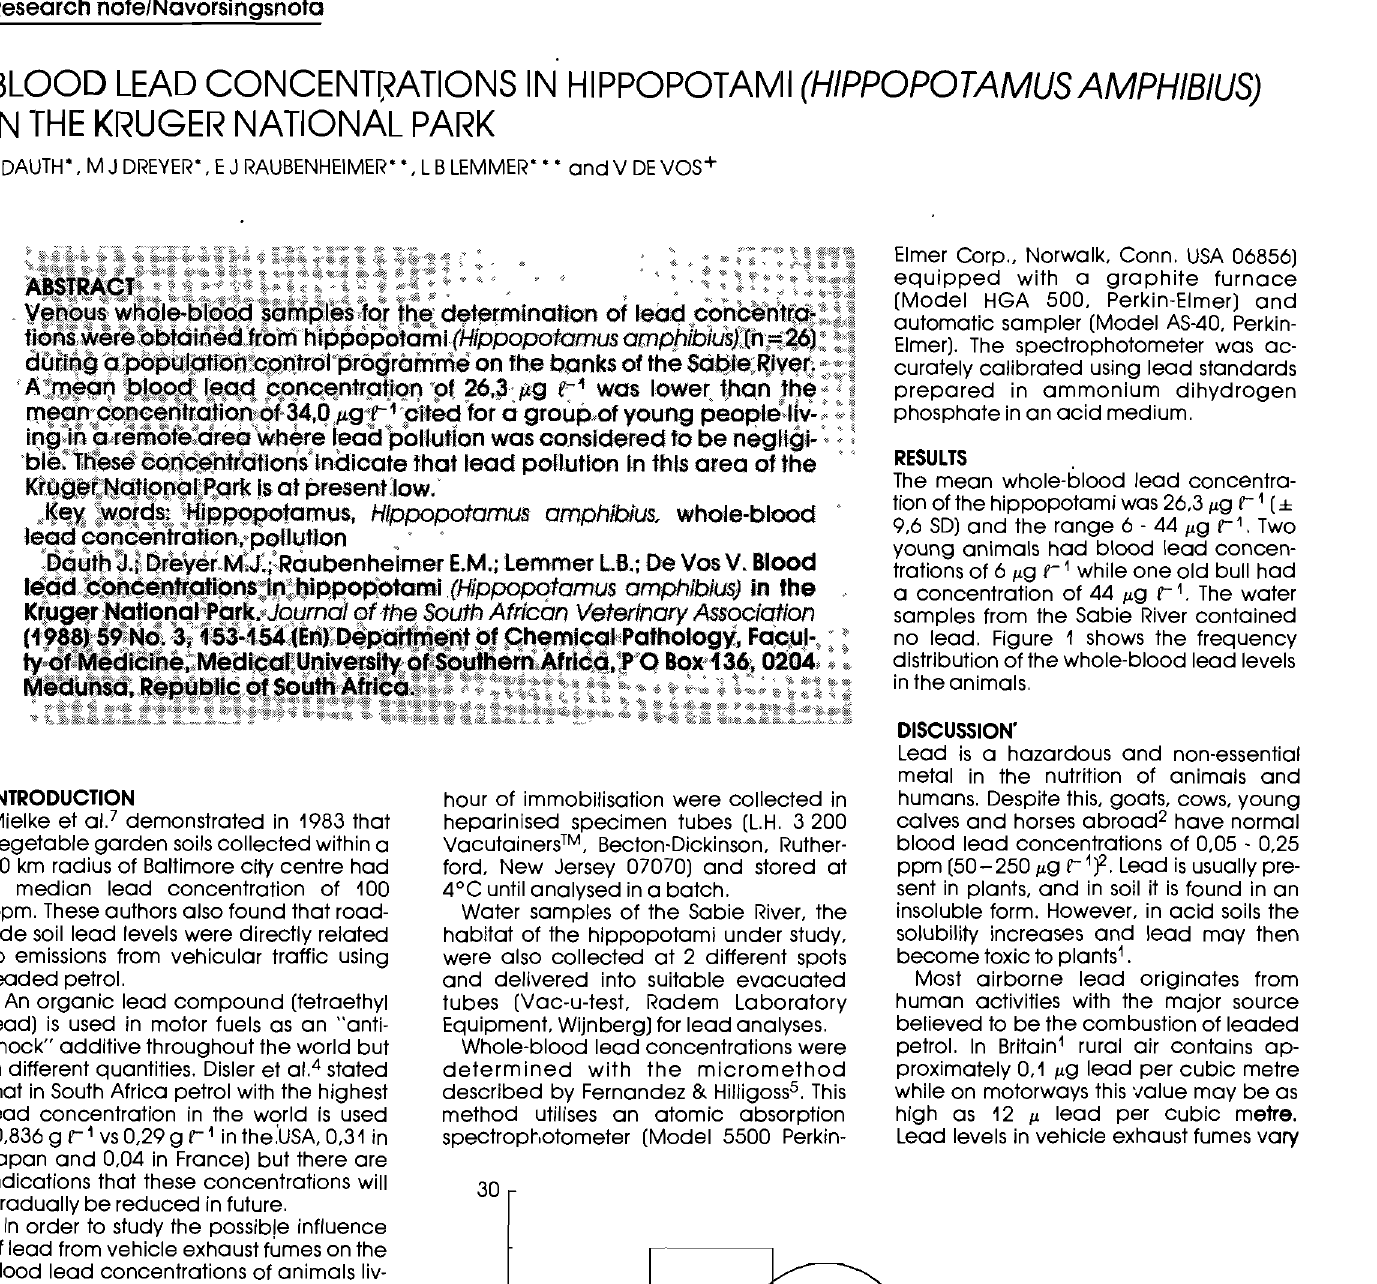
Fig. 1: The frequency distribution of whole-blood lead (p.g y-1) in 26